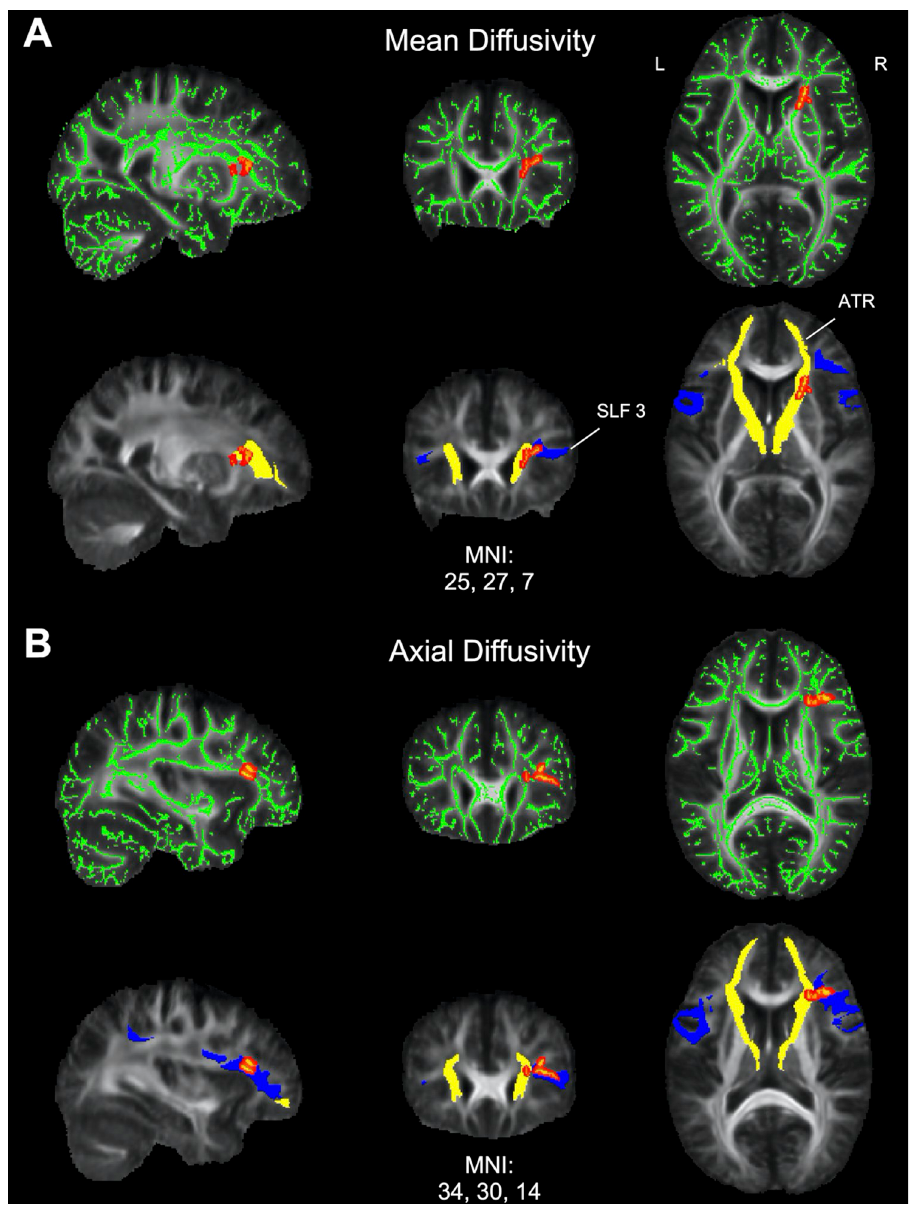
Fig 4. Relationship between diffusion tensor imaging (DTI) metrics and duration of illness (DOI) in PTLD. (A) Mean diffusivity (MD) results. Top: Area of significant correlations between MD and DOI overlaid on the mean fractional anisotropy (FA) map and white matter skeleton (green). Positive correlations are displayed in red (FWE- corrected p < .05). There were no significant negative correlations. Bottom: MD results overlaid with two long range white matter pathways for visualization showing overlap with anterior thalamic radiation (ATR; yellow) and superior longitudinal fasciculus 3 (SLF 3; blue). (B) Axial diffusivity (AD) results. Top: Area of significant correlations between AD and DOI overlaid on the mean FA map and white matter skeleton (green). Positive correlations are displayed in red (FWE-corrected p < .05). There were no significant negative correlations. Bottom: AD results overlaid with ATR (yellow) and SLF 3 (blue) showing overlap for localization. L = left, R = right